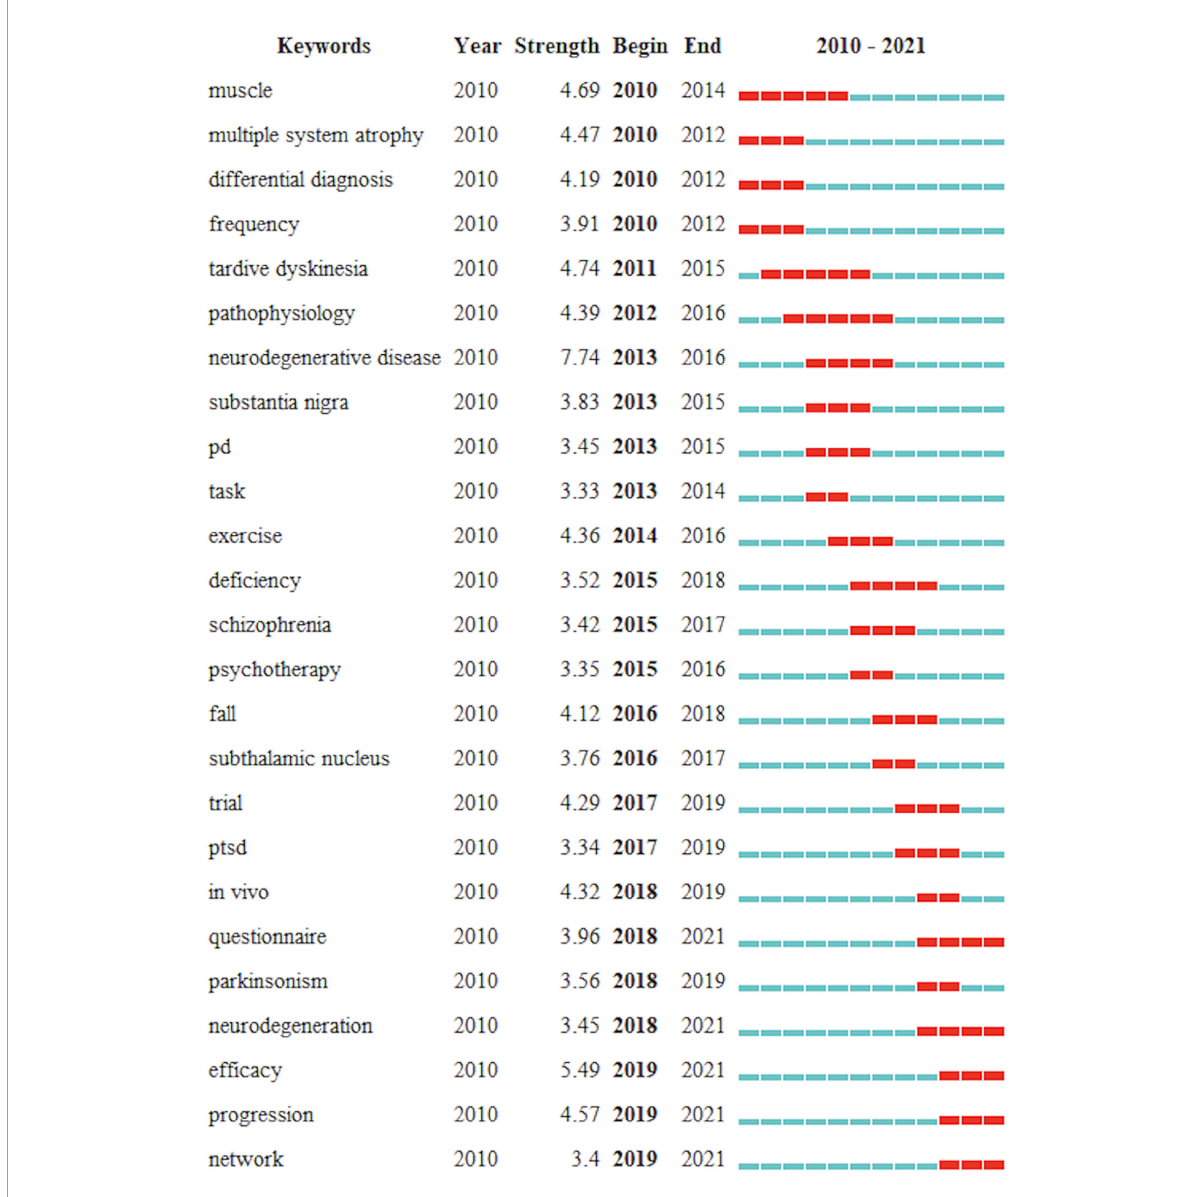
FIGURE10 The top 25 keywords with the strongest burst value. Red bar represents keywords with higher co-citation in the time